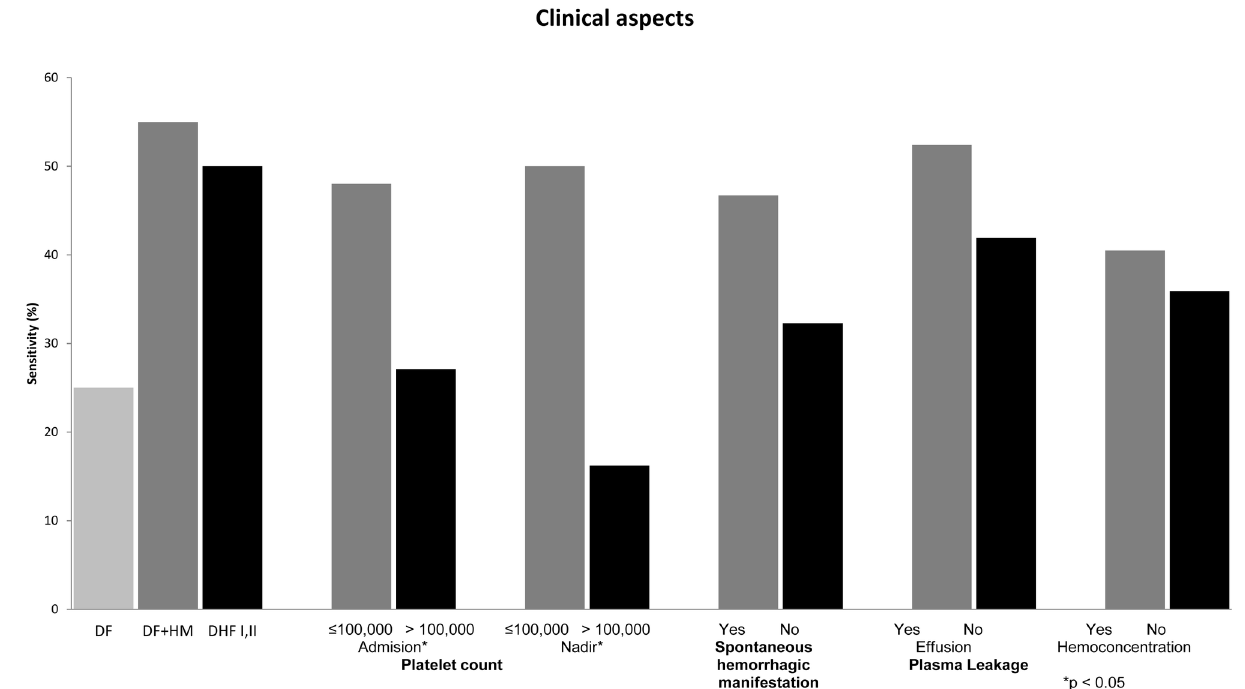
Figure 1. Sensitivity of the NS1 antigen test according to diagnosis category and clinical variables in secondary dengue cases. doi: